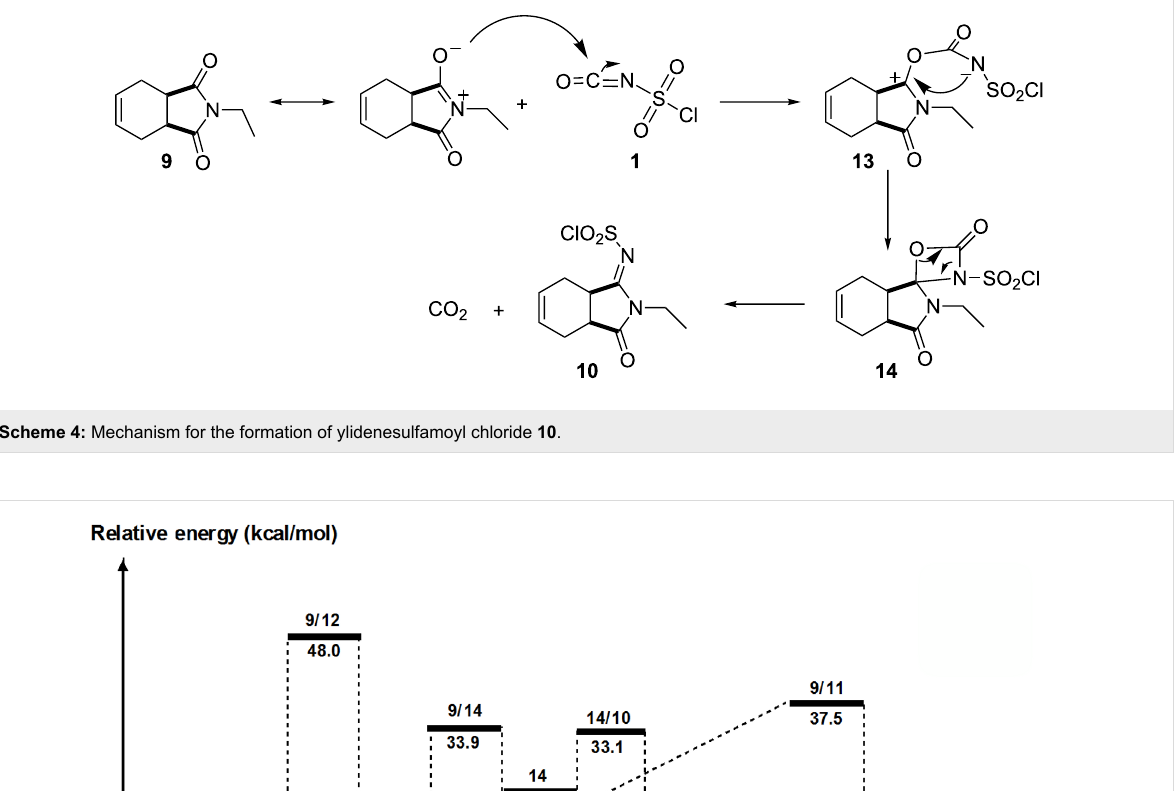
13 C NMR spectra were recorded on Varian 400 and Bruker 400 spectrometers. Elemental analyses were performed on a Leco CHNS-932 instrument. The melting points were measured with Gallenkamp melting point devices. X-ray crystallography was performed using a Rigaku R-AXIS RAPID IP diffractometer. HRMS: electron-spray technique (M + /M − ) from the solution in MeOH (Waters LCT PremierTM XE UPLC/MS TOF (Manchester, UK)). All the computations were performed using the Gaussian 09 program package. The energies of all the struc- tures are on the B3LYP/6-311G++(d,p)